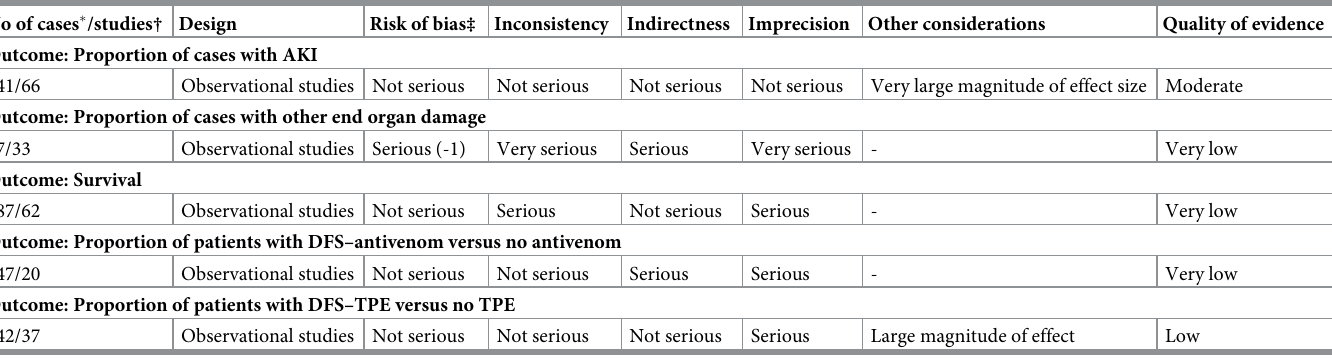
Table 5. Quality of accumulated evidence by GRADE